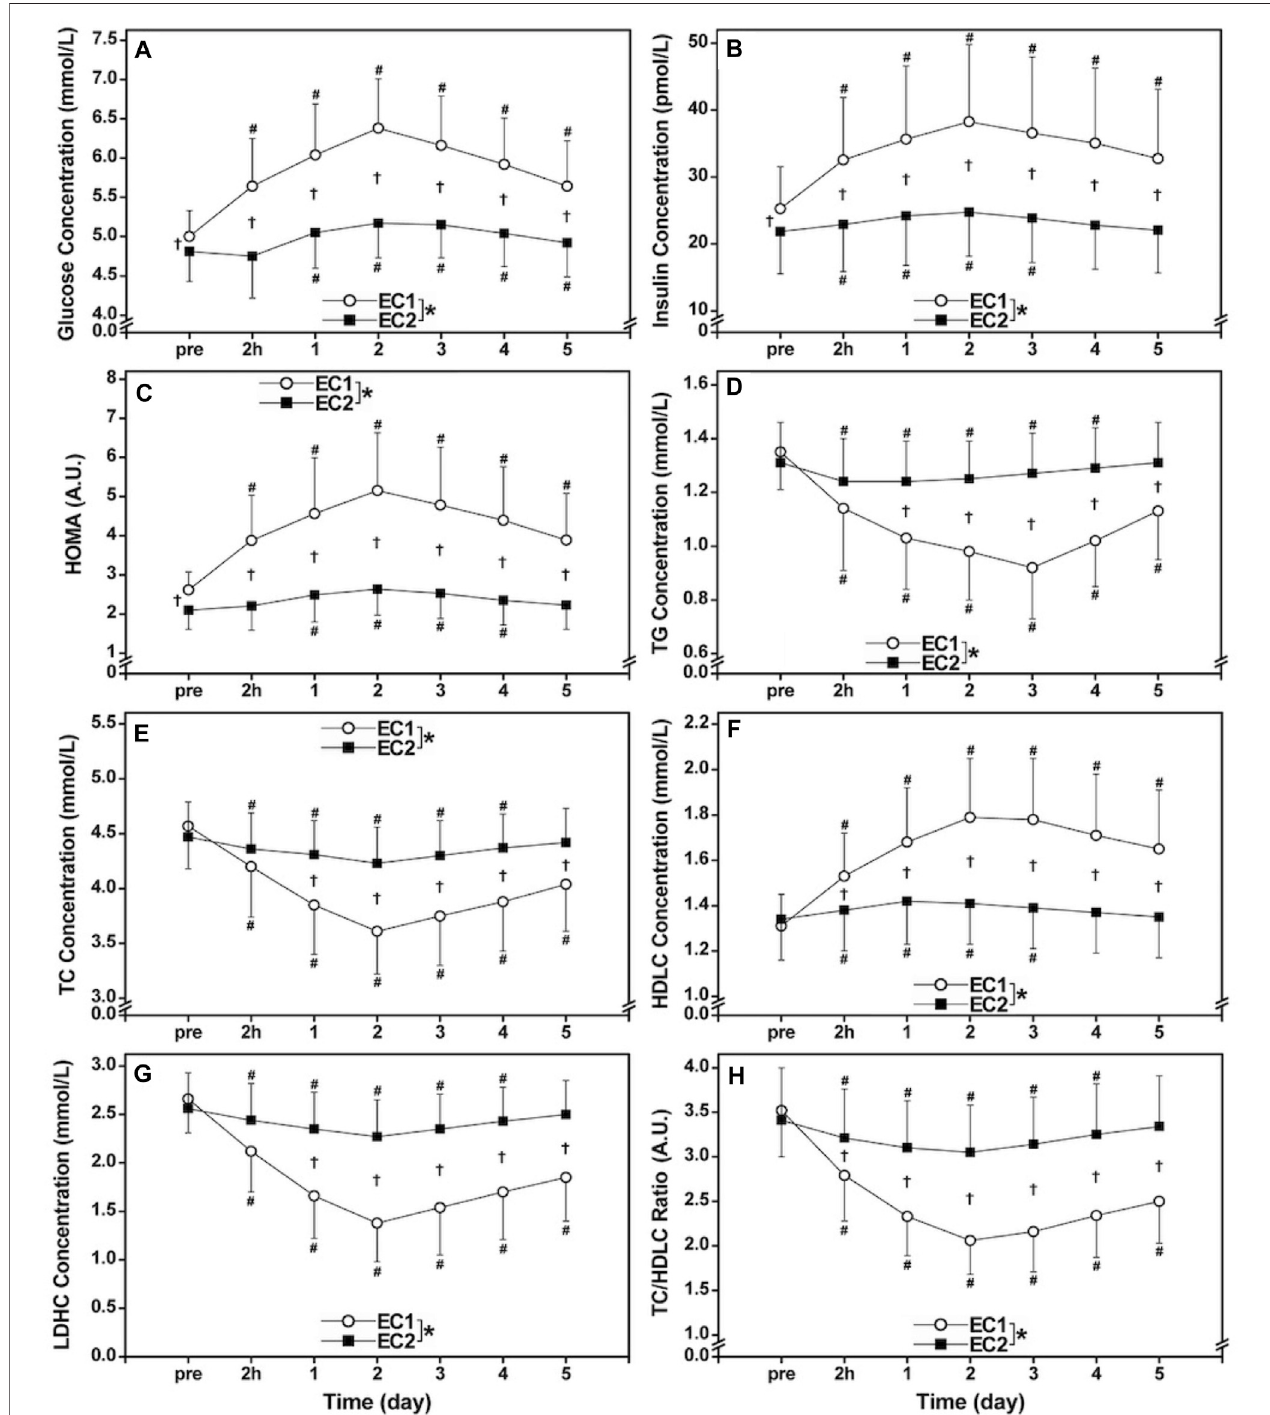
FIGURE 1 | Changes (mean ± SD) in serum glucose (A) , insulin (B) , and homeostasis model assessment (HOMA, (C) , triacylglycerols [TG, (D) ], total [TC, (E) ] and high- [HDLC, (F) ] and low-density lipoprotein cholesterols [LDLC, (G) ] concentrationsaswell asTC/HDLCratio (H) before(pre) and 2 h (2 h), 1,2, 3, 4,and 5 days (1 – 5) after the fi rst bout (EC1) and second bout (EC2) of whole-body eccentric exercises. *: a signi fi cant ( p < 0.05) difference between EC1 and EC2 based on the interaction effect shown bythe ANOVA. † : a signi fi cant ( p < 0.05) difference between bouts for each time point based on the post hoc test. # : a signi fi cant ( p < 0.05) difference from the baseline.